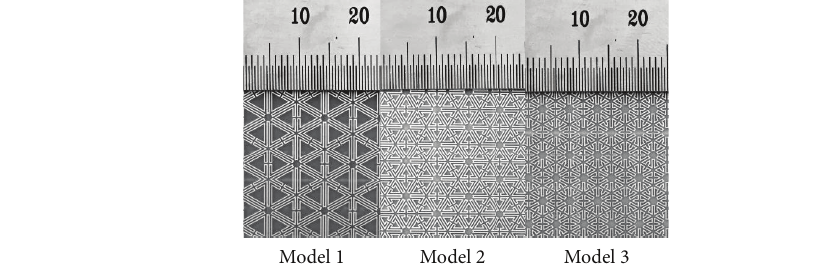
calculated results and that the structure has stable frequency response